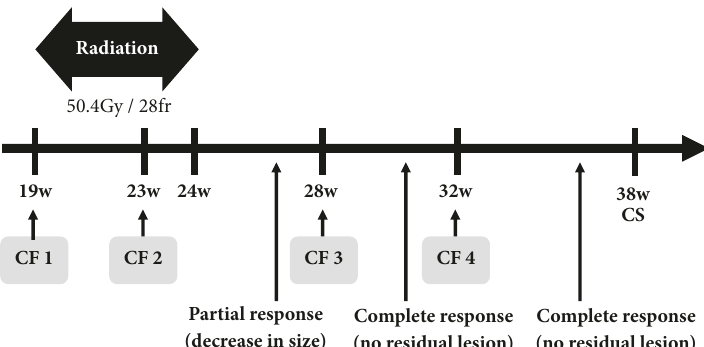
Figure 3: The time course of treatment. The horizontal axis indicates gestational weeks. CF, cisplatin 60 mg/m 2 , 5-fluorouracil 750 mg/m 2 ; CS, cesarean